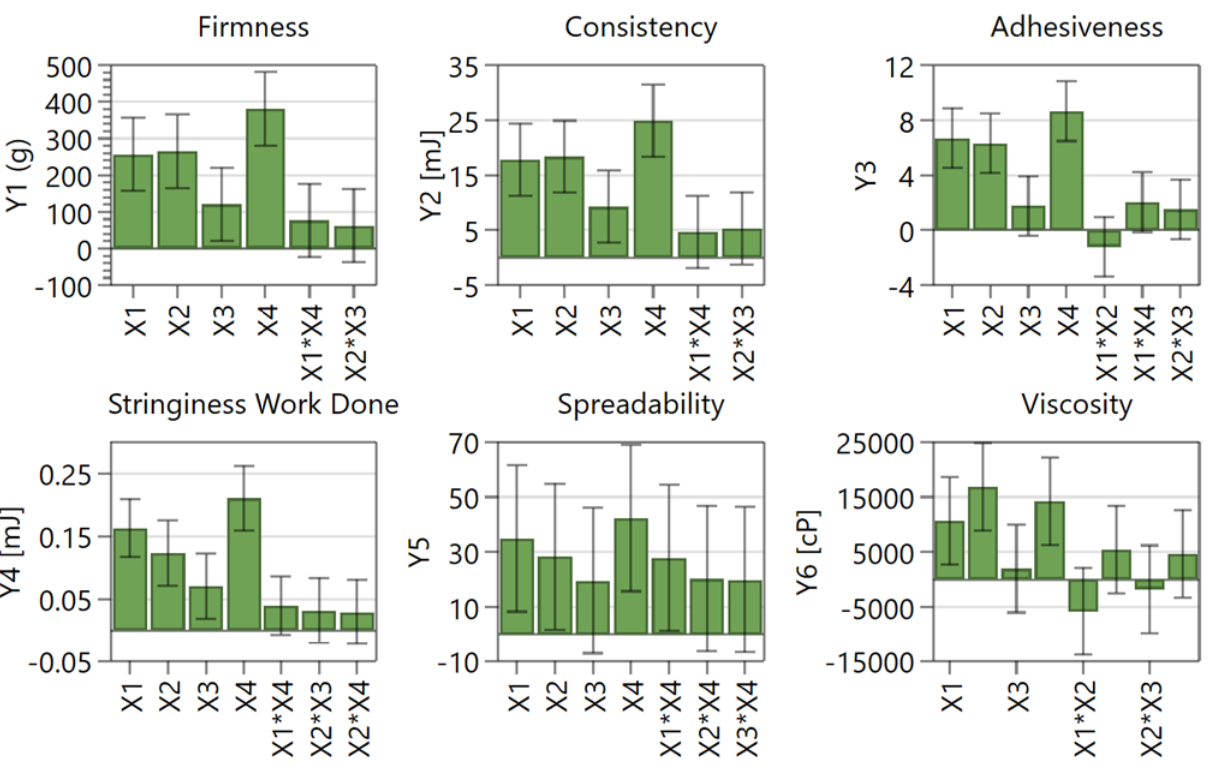
Figure 6. Coefficient plots (X1, emulsifier ratio, X2, co-emulsifier ratio, X3, thickening agent ratio, and X4, oily phase ratio; Y1, firmness; Y2, consistency; Y3, adhesiveness; Y4, stringiness; Y5, spreadability; Y6, viscosity).